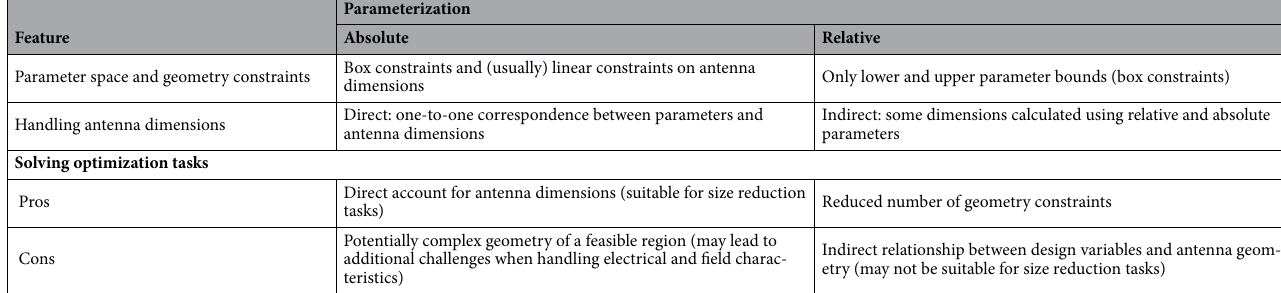
Table 2. Absolute versus relative parameterization: Basic properties.